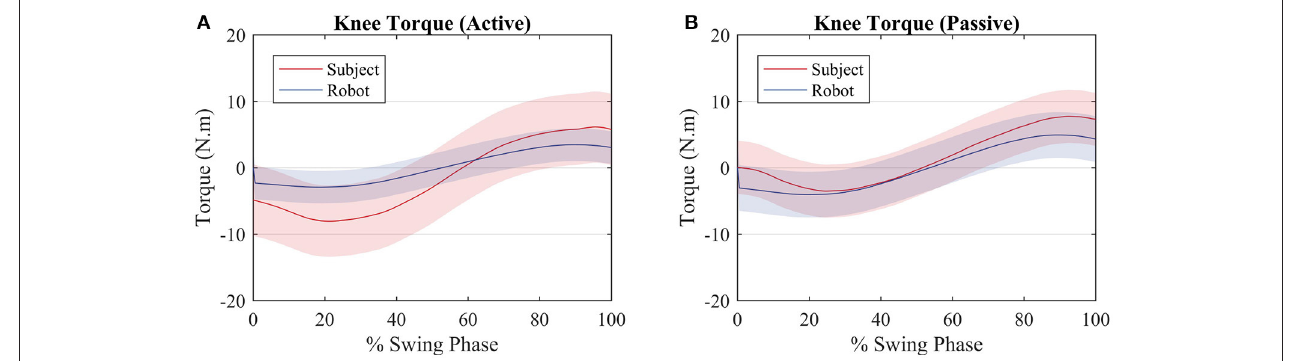
FIGURE 6 | Average torque exerted by the subjects (red) and by the robot (blue) for an (A) active walk and a (B) passive walk. Shaded regions denote the standard deviation of the measurements.